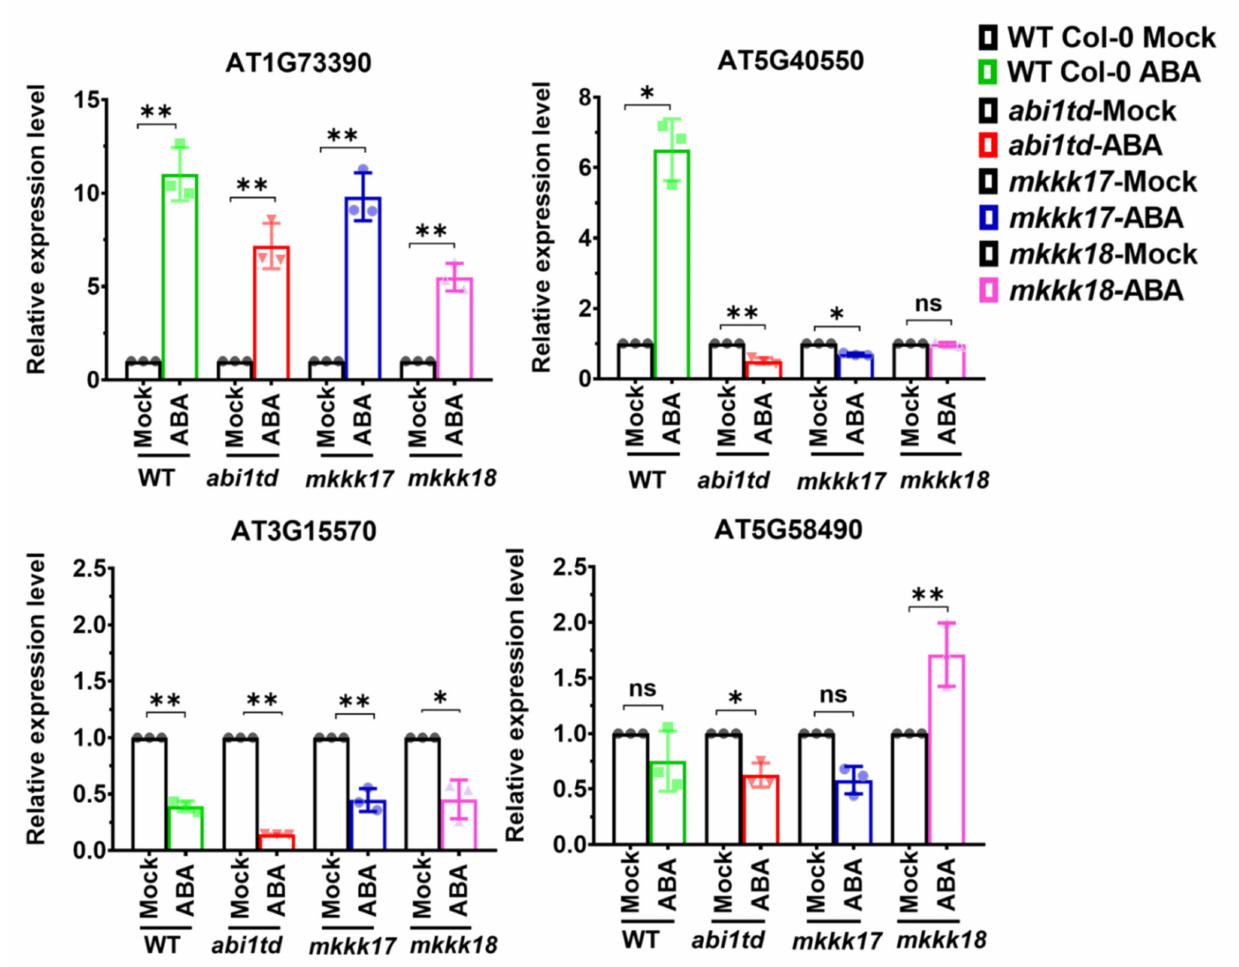
Figure 10. Relative transcript abundance of selected target genes of novel miRNAs identified as ABA-responsive in this study by RT-qPCR. Target gene expression profiling data of randomly selected target genes of novel miRNAs in Arabidopsis WT Col-0, abi1td , mkkk17 , and mkkk18 mutants before or after 4 h of 100 µ M ABA treatment (mock- and ABA-treated). The x -axis represents genotype names, while the y -axis represents the relative expression level of miRNA target genes. The expression levels are normalized to the level of 18S as internal control. Data from qRT-PCR are means of three biological replicates, each of which has three technical replicates ( n = 9). Error bars represent ± SD (standard deviation) from triplicates. Student’s t -test was performed on mock- and ABA-treated results of qRT-PCR, and statistically significant treatments are marked * ( p -value ≤ 0.05), ** ( p -value ≤ 0.001), or ns